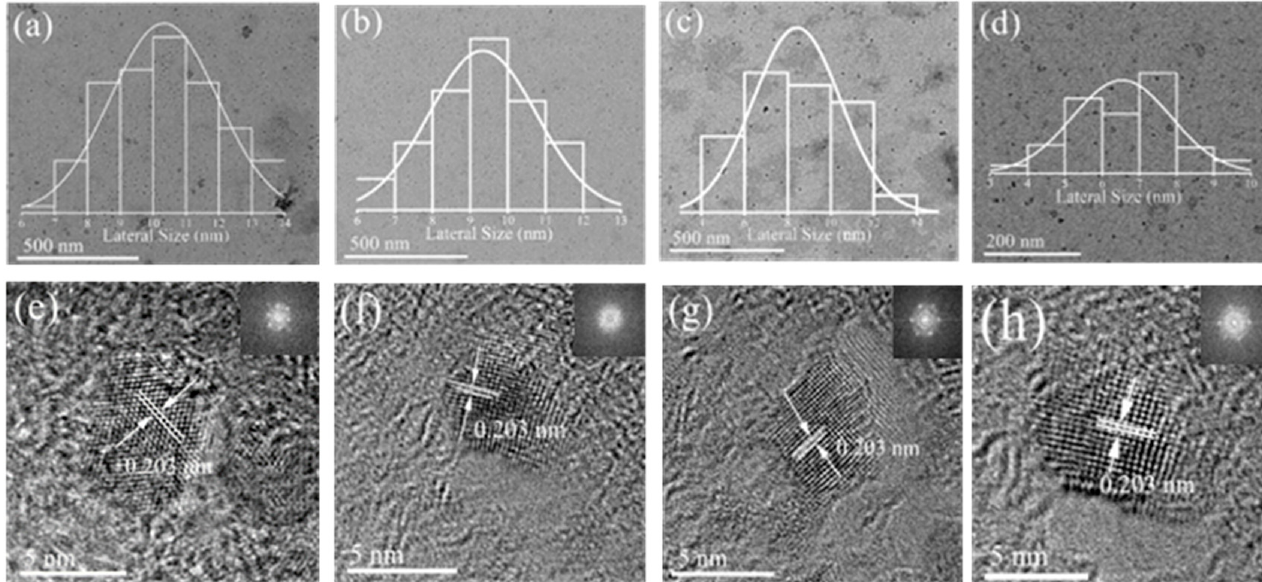
Figure 1. TEM images of four separated GQDs dialyzed with dialysis bags of 14,000 Da ( a ), 7000 Da ( b ), 3500 Da ( c ), and 1000 Da ( d ) molecular weights; insets are corresponding lateral size distributions. High-resolution TEM images of four separated GQDs dialyzed with dialysis bags of 14,000 Da ( e ), 7000 Da ( f ), 3500 Da ( g ), 1000 Da ( h ) molecular weights; insets are corresponding FFT patterns.